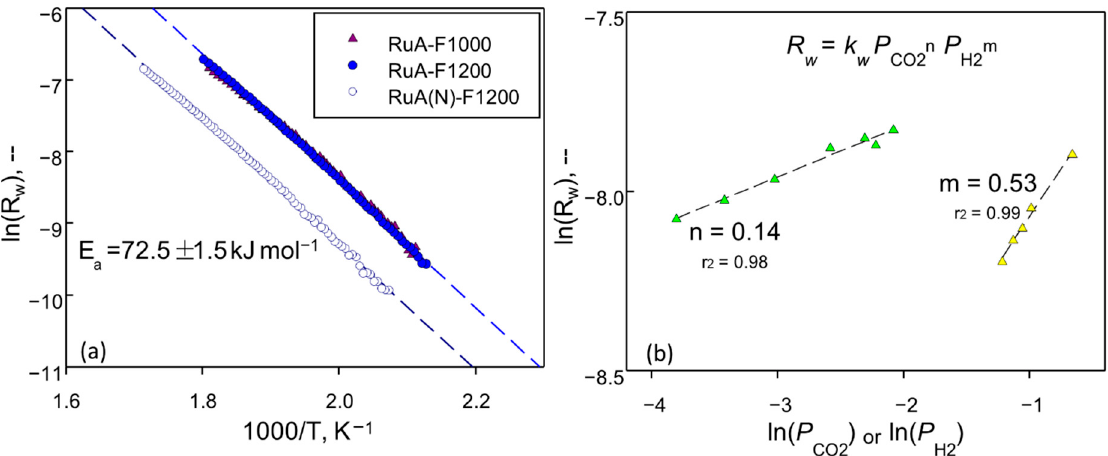
Figure 7. ( a ) Arrhenius plots for the catalytic hydrogenation of CO 2 over RuA-F1000, RuA-F1200, and RuA(N)-F1200 foam catalysts. ( b ) Effect of the partial pressure of CO 2 and H 2 on the catalytic hydrogenation rate at a fixed temperature (230 °C) over RuA-F1000 and corresponding apparent reaction orders.